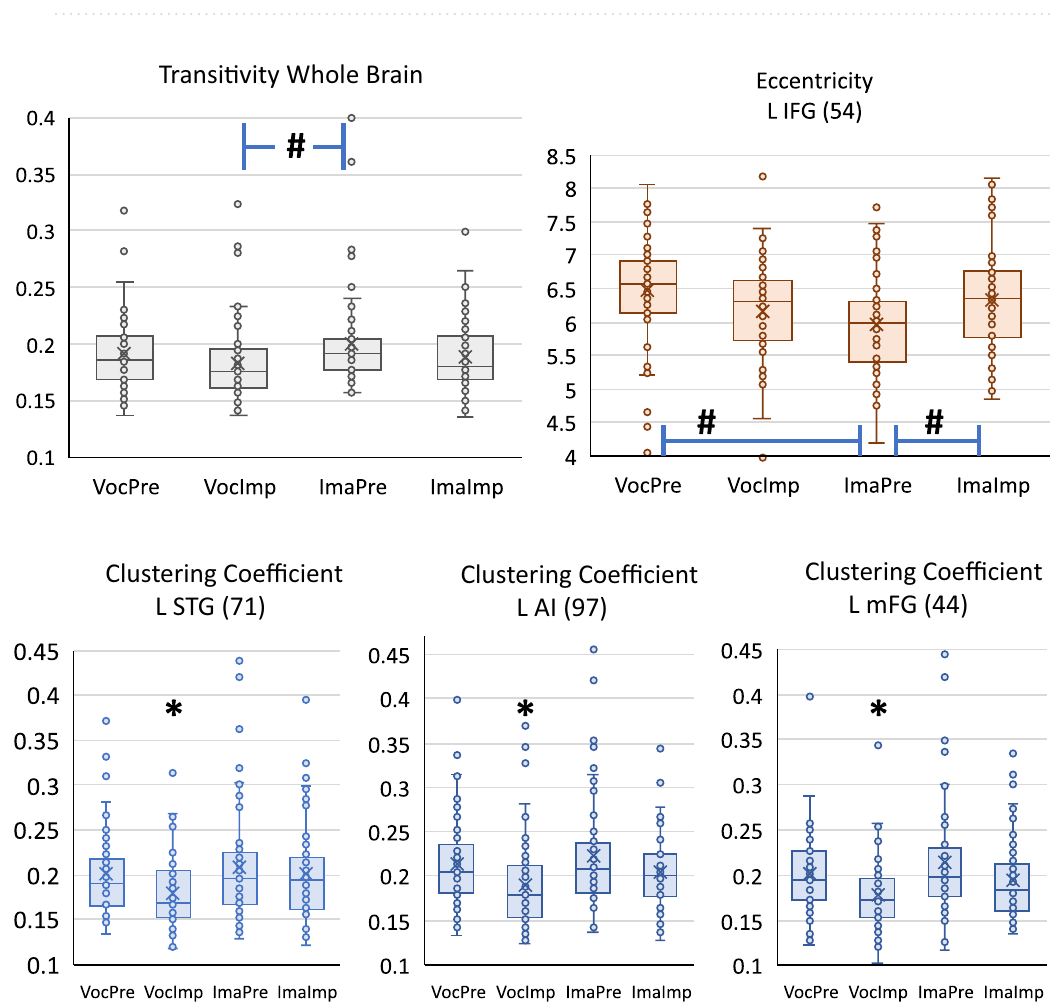
Figure 4. Statistical analysis of task differences. This figure displays only the significant FDR corrected p-values from the One-Way ANOVA performed for all four tasks. In addition, non-significant tests are plotted blank.